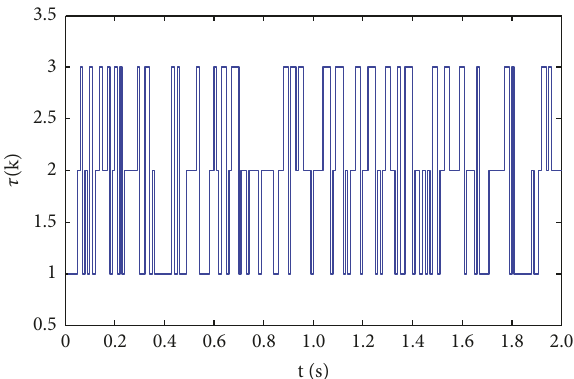
Figure 2: Distribution of system time delay.